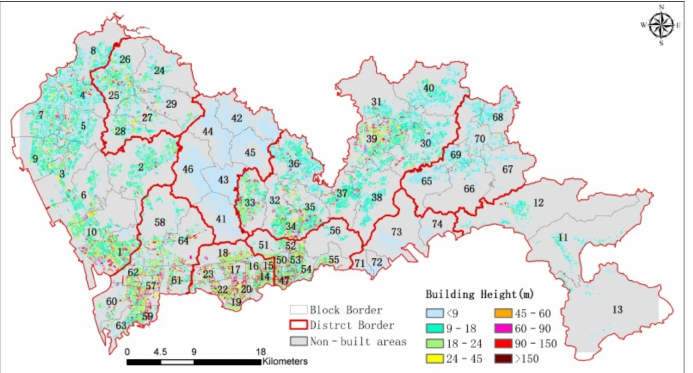
Figure 10. Building height distribution in Shenzhen.